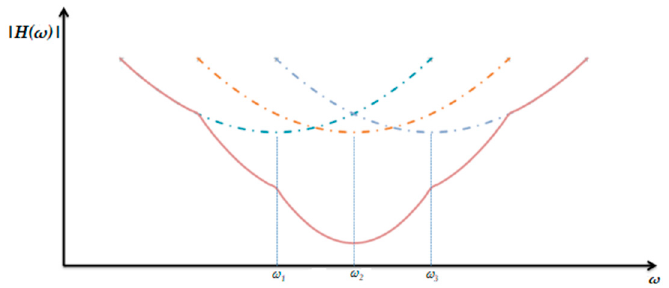
Figure 4. The transfer function for a three-cascade resonator with three different resonance frequencies.